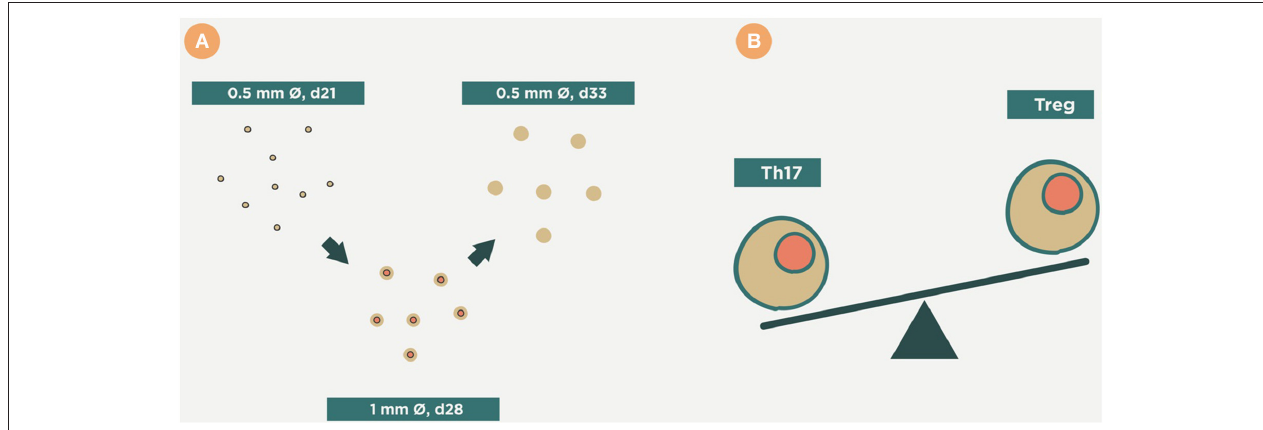
FIGURE 10 | Therapeutic approach of Mycobacterium manresensis . This picture illustrates how administration of M. manresensis increases the Treg response and results in a decrease in the Th17 response (B). This stops the neutrophilic infiltration of the lesions, and stops their growth, and it has been speculated that this might provide sufficient time for them to become encapsulated (A) . This might avoid the progression toward coalescence, liquefaction, and cavitation.